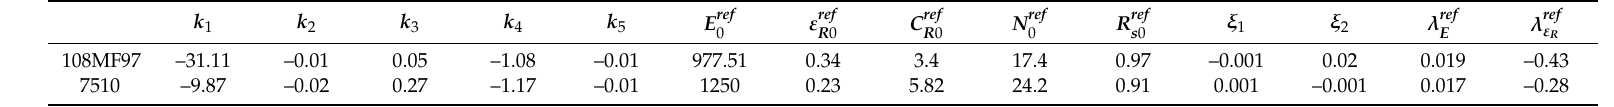
Table 2. The coe ffi cients and the reference parameters for